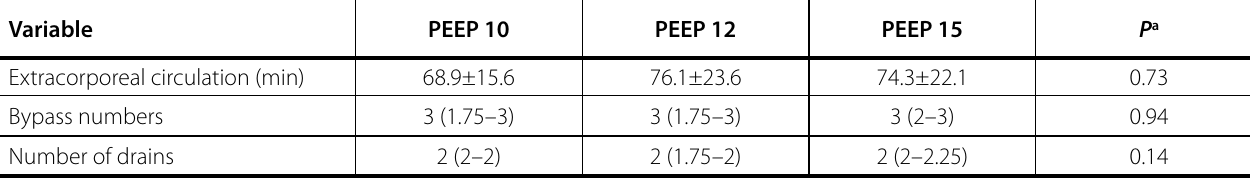
Table 2. Clinical and surgical characteristics of patients undergoing myocardial